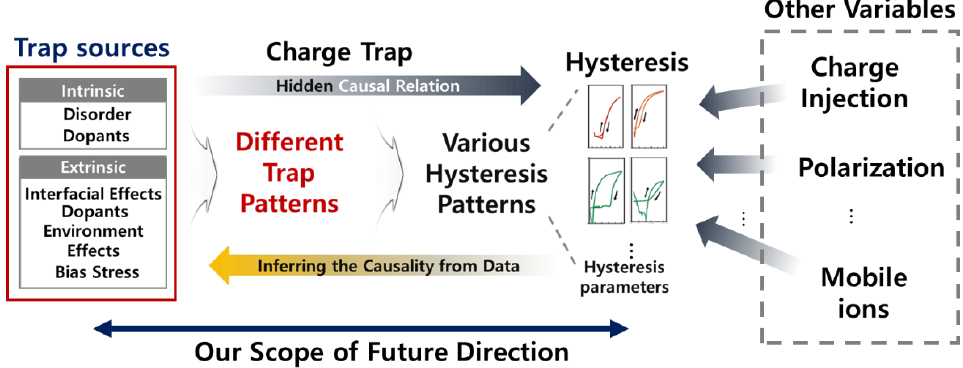
Figure 12. Scheme of limitations of quantification of causality between charge traps and hysteresis in OFETs.